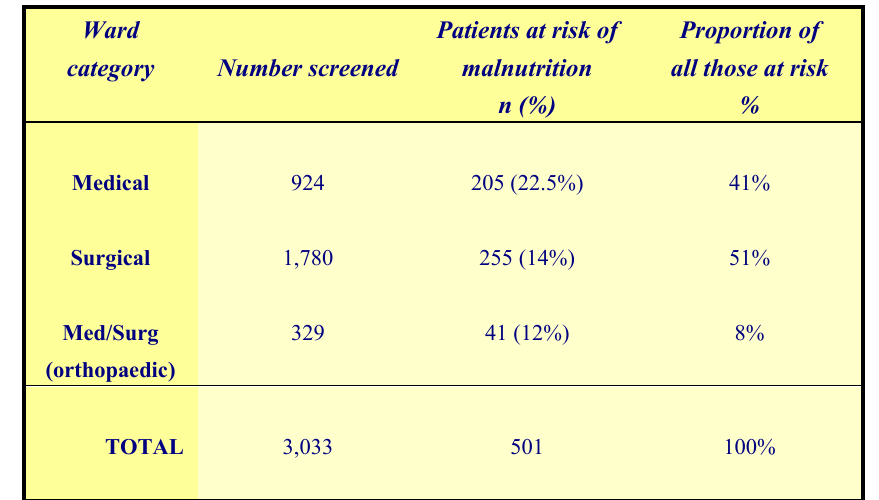
Table 3. Malnutrition risk by MST score ≥ 2 by hospital ward category